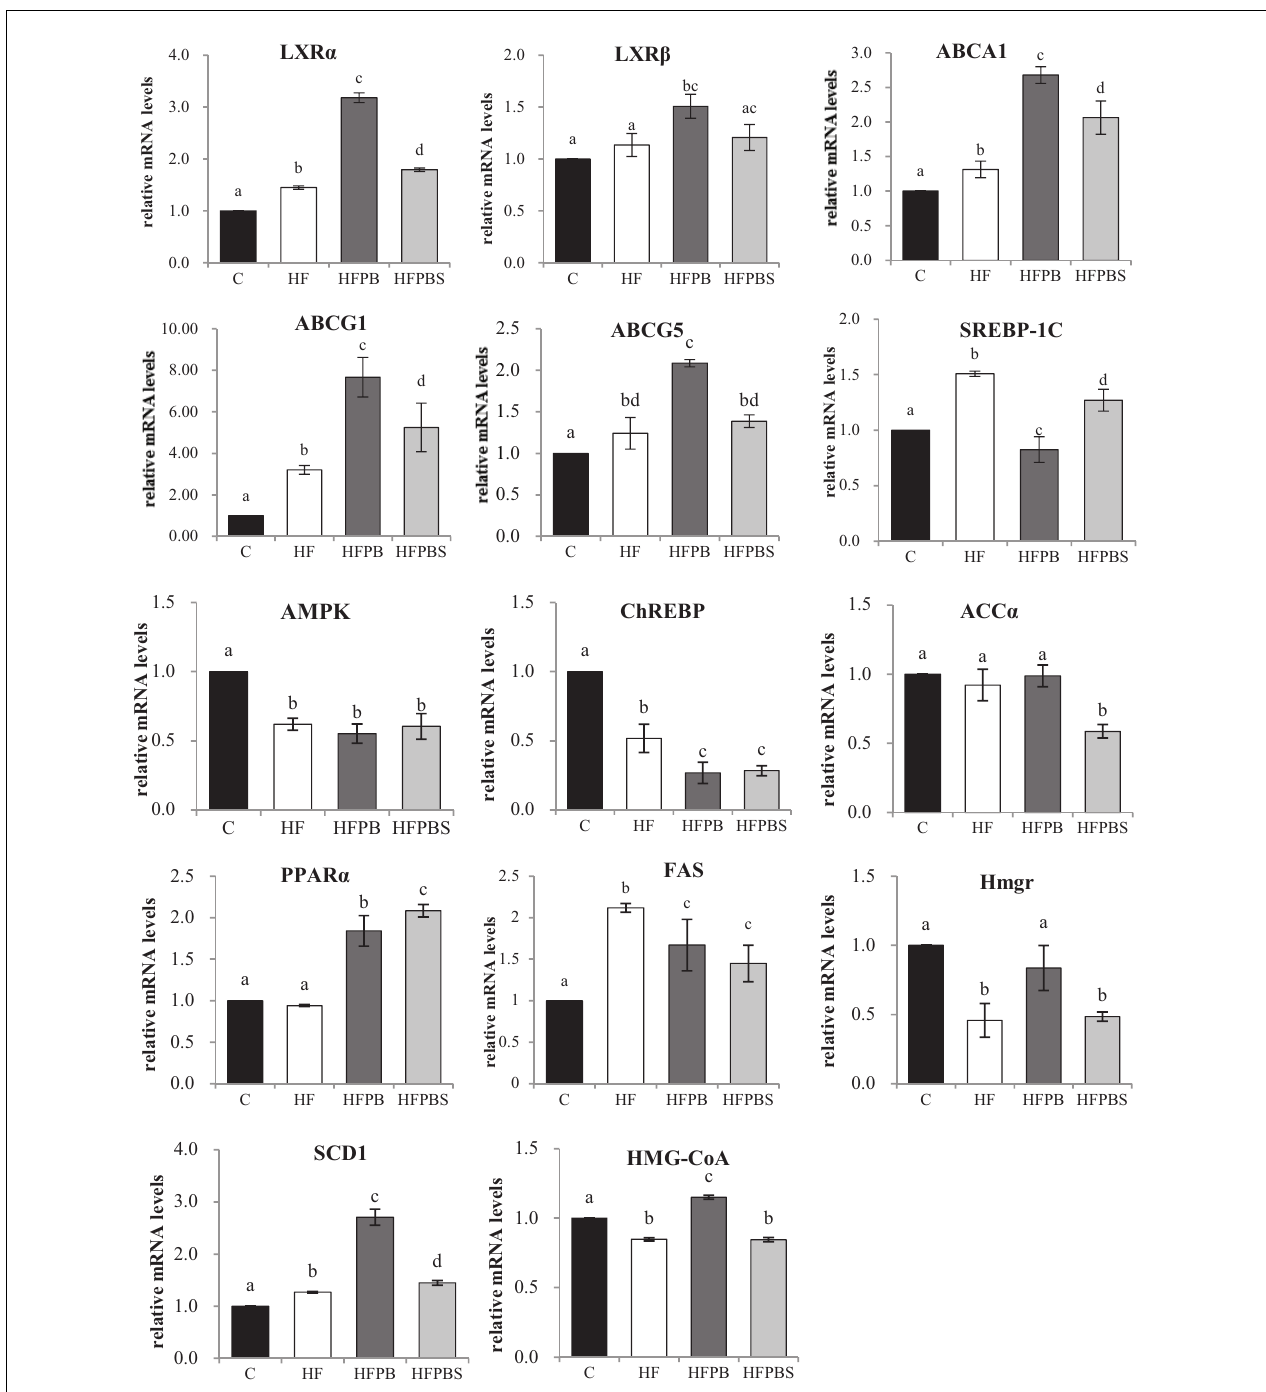
FIGURE 2 | Effects of diet on the transcription of genes related to lipid metabolism in freshly isolated livers. The total RNA was extracted, reverse transcribed to cDNA, and analyzed to detect the transcription of genes using RT-PCR. Gene transcription is reported as the mean ± SD ( n = 6) of the fold change relative to the C group. Error bars with different letters indicate significant differences ( P <